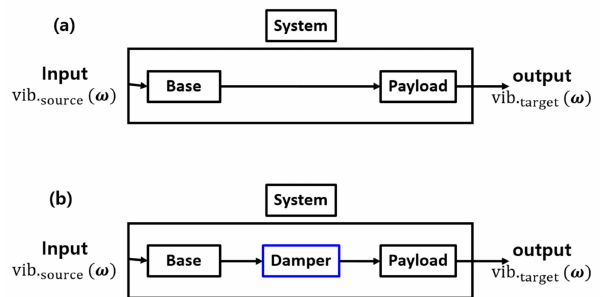
Figure 4. Vibration pathway of a surveillance system in a drone: ( a ) original pathway and ( b ) proposed